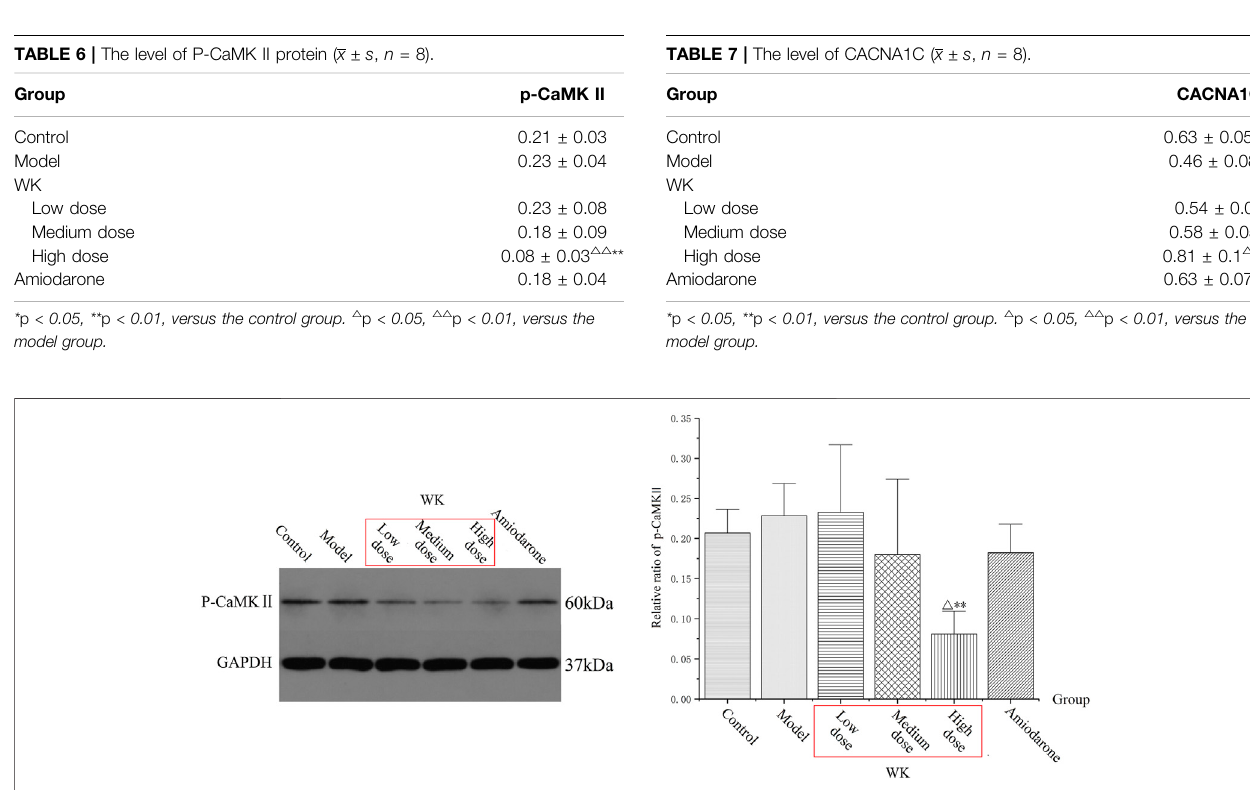
FIGURE 6 | The levels of p-CaMKII protein. ( x ± s , n (cid:1) 8) * p < 0.05, ** p < 0.01, versus the control group. △ p < 0.05, △△ p < 0.01, versus the model group.